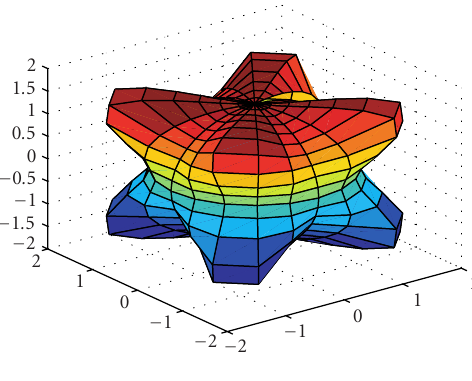
Figure 3.2. Fresnel’s elasticity